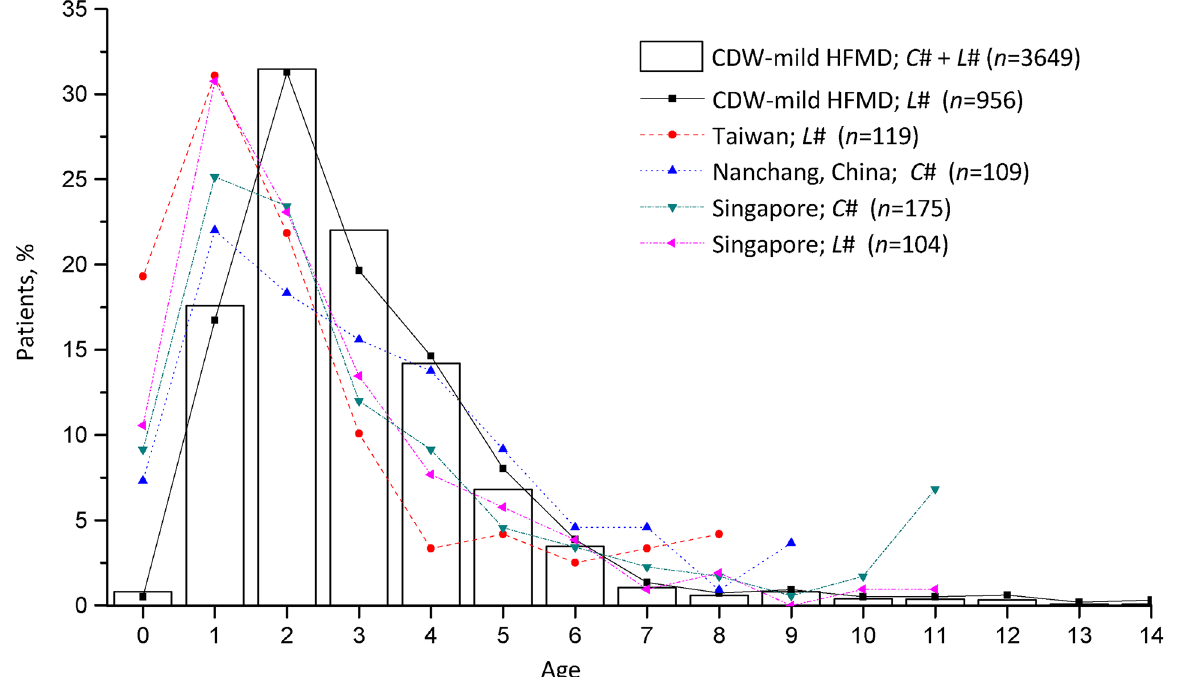
Fig 2. Age distribution of mild HFMD from the Clinical Data Warehouse System and other reports. C #, probable data; L #, laboratory confirmed